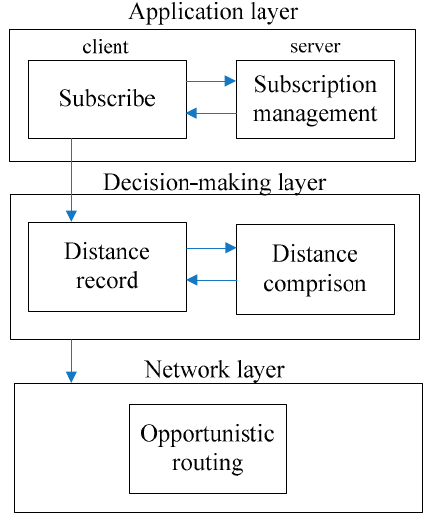
Figure 1. The structure of DOPS.